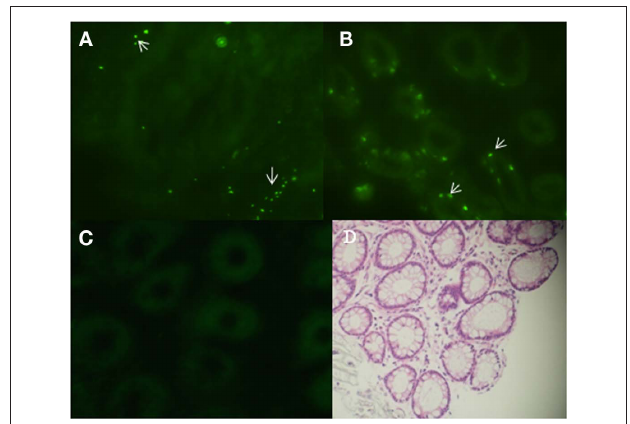
FigUrE 1 | Escherichia coli O157:H7 penetrated into the crypts of the bovine terminal rectal mucosa. Cattle were challenged with E. coli O157:H7 43894 GFPuv by standard rectal application of bacteria and negative control animals received no bacteria. Rectal mucosal biopsies were taken using a curette 4 days post-challenge. Tissue was processed, cryosectioned, and observed by light or fluorescent microscopy. Representative biopsy sections from O157 culture-negative and -positive cattle are shown. The sections were cut sequentially from the lumen side. (A) E. coli O157:H7 43894 GFPuv (arrow) visible 10 μm from the lumen surface and (B) around crypts at 30–40 μm from the lumen surface. (C) Biopsy tissue section from an O157 culture-negative animal. (D) Hematoxylin and eosin-stained section showing crypts of the terminal rectal mucosa. Crypts show autofluorescence with the fluorescence microscopy (original magnification × 200).